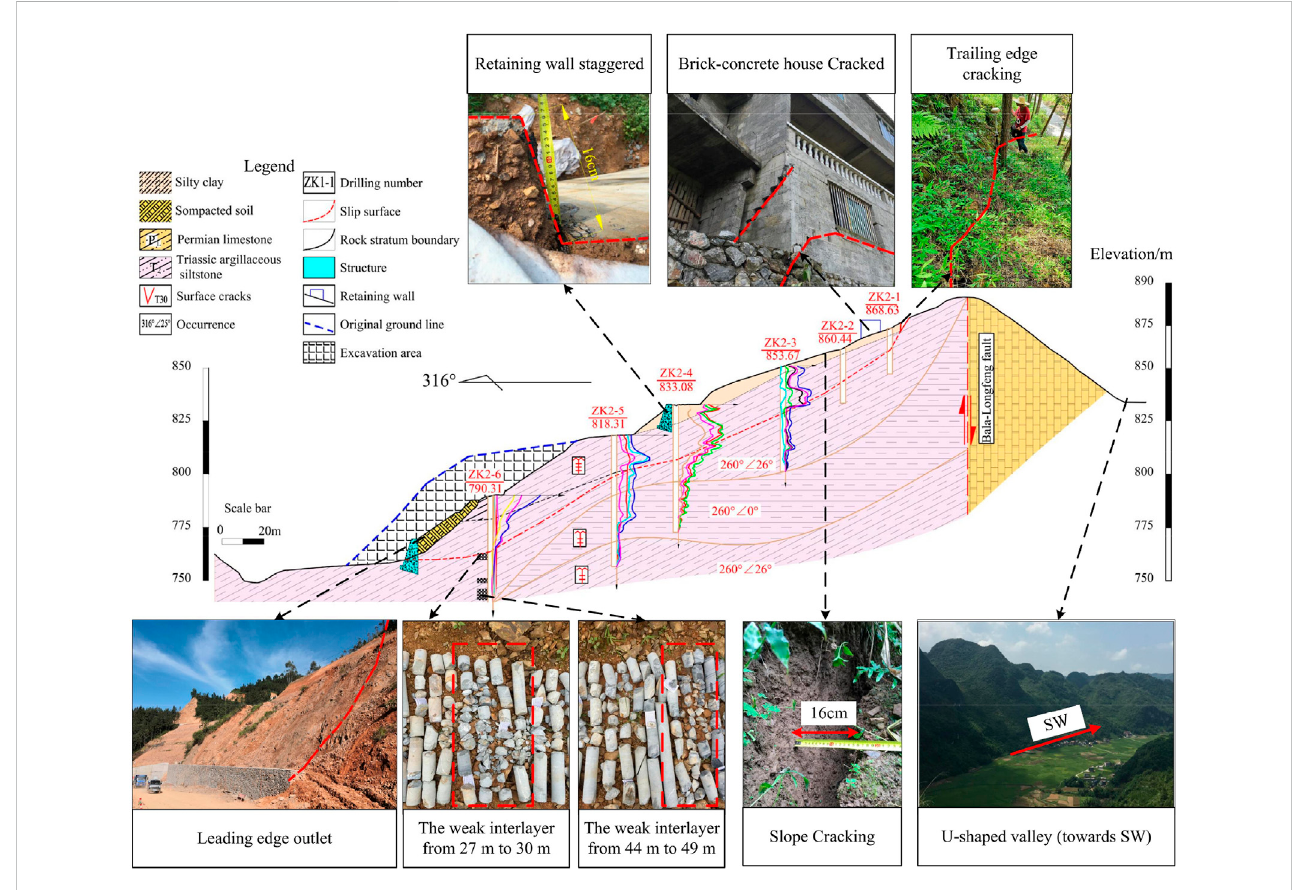
FIGURE 3 Geological pro fi le of the main axis of a typical landslide.